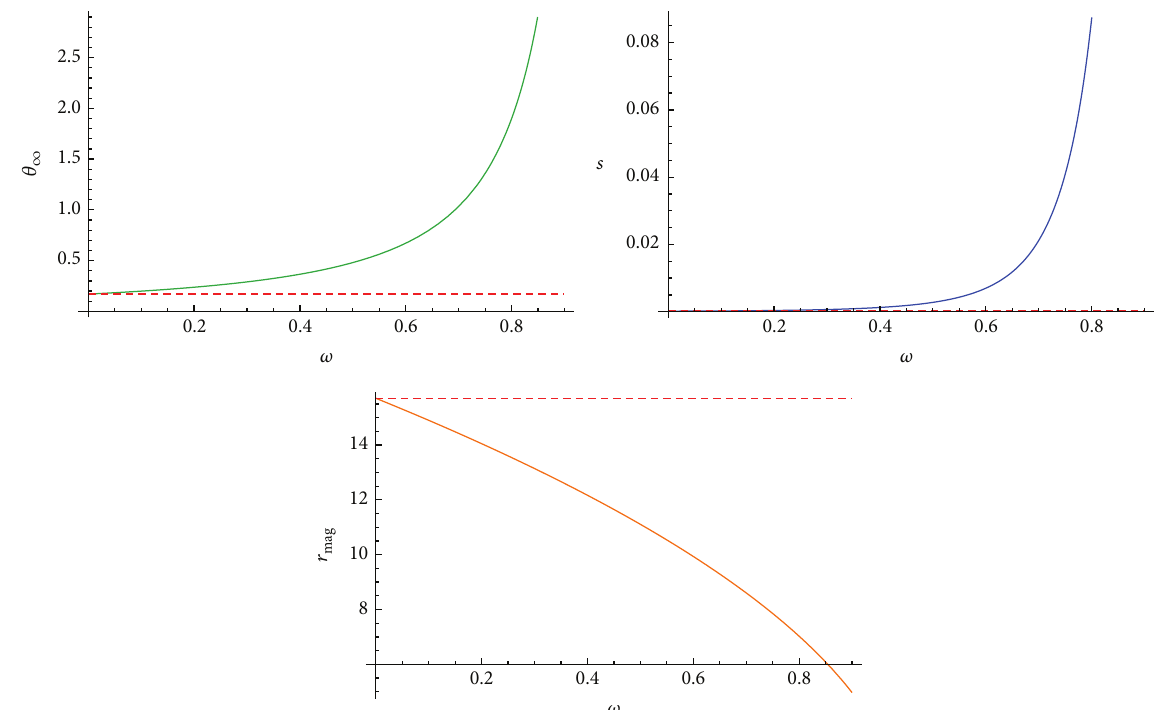
Figure 6: Plots of the observables corresponding to 𝜔 . Dashed lines show the value for the Schwarzschild BH.